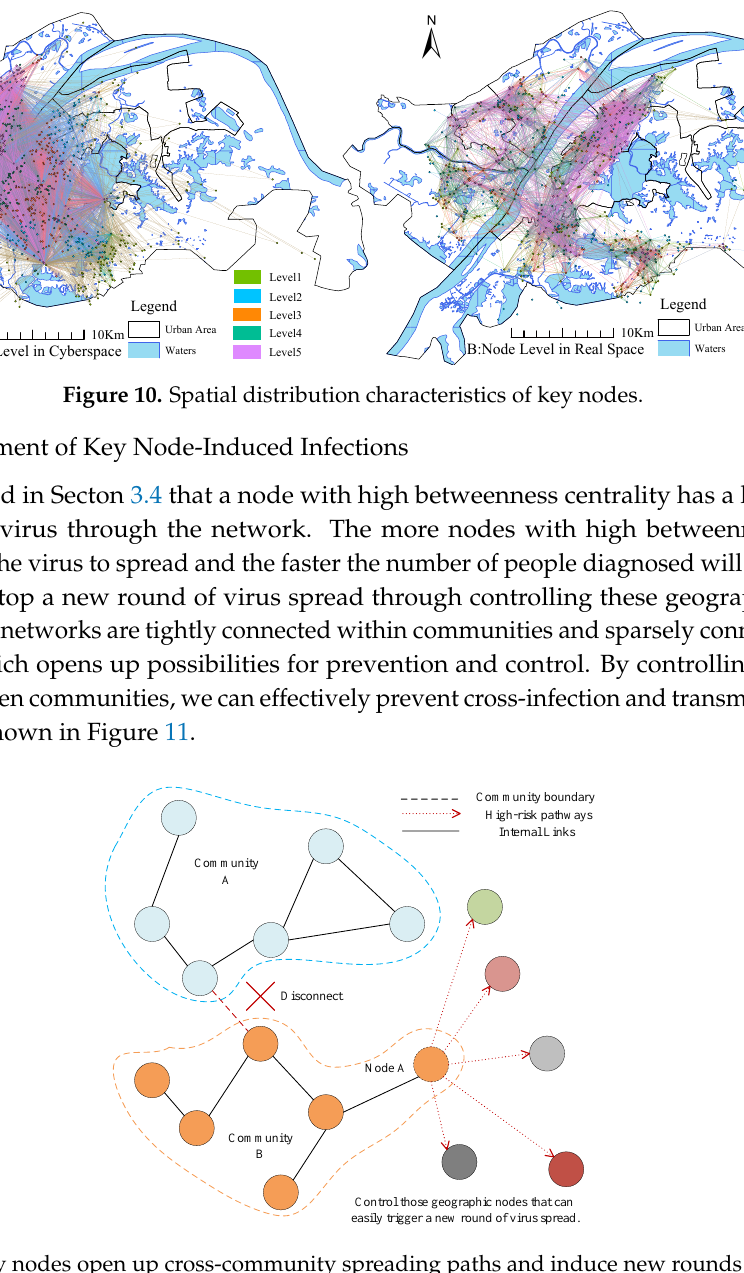
Figure 11. Key nodes open up cross-community spreading paths and induce new rounds of